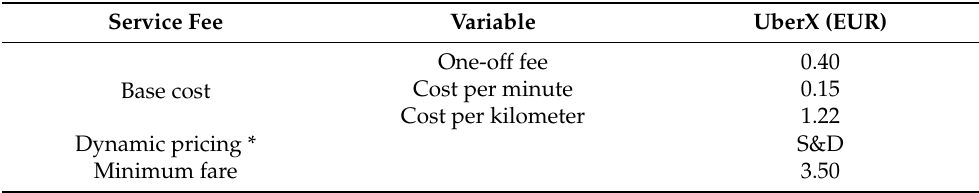
Table 1. Factors that influence UberX fares in Madrid (Adapted from El Confidencial, 2019